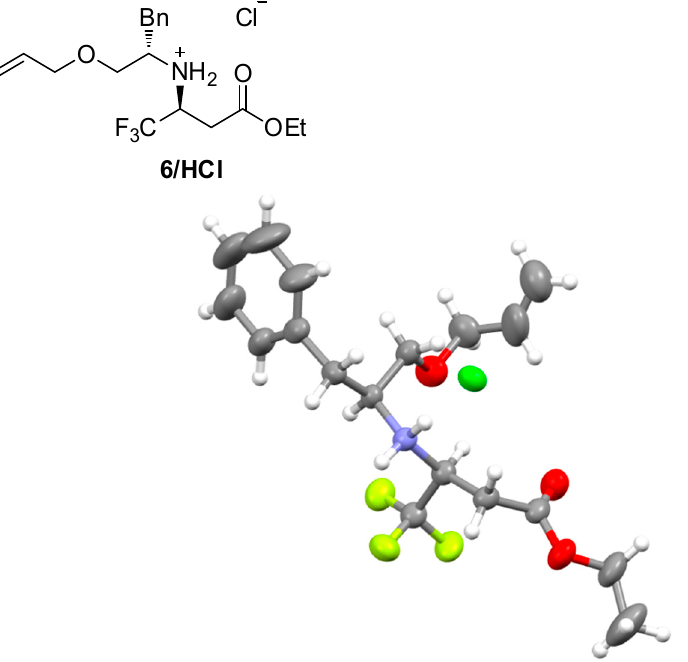
Figure 2. X-ray determined structure of chiral intermediate ( S,S ) 6 /HCl.